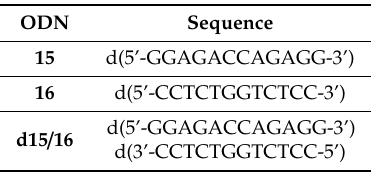
Table 1. The oligodeoxynucleotides (ODNs) 15 and 16 used in this study to form the model duplex DNA d15/16 .